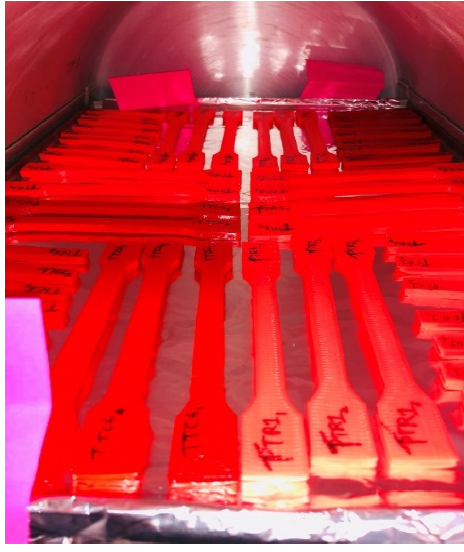
Figure 10. 3D-printed samples annealed in the oven.